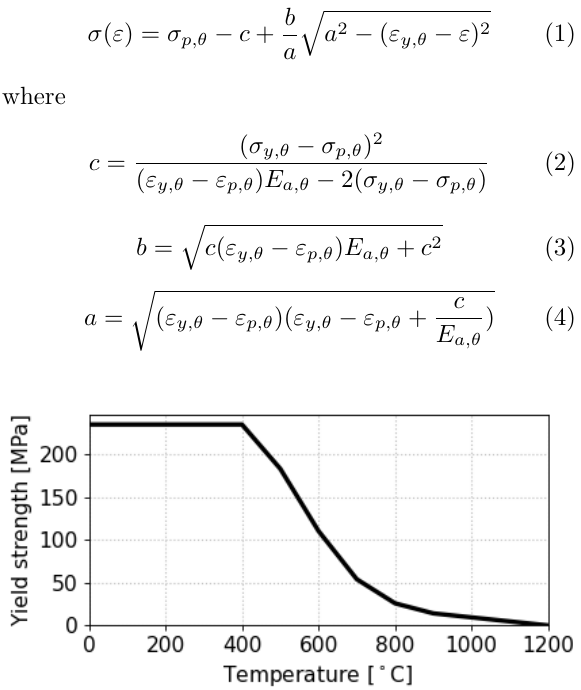
Figure 16. Temperature-dependent effective yield strength of steel, given by EC3.